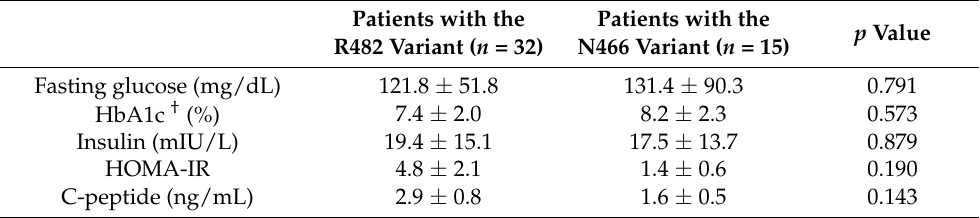
Table 4. Analytical data of FPLD2 patients depending on the variant in exon 8 of the LMNA gene. Patients with the Patients with the R482 Variant ( n = 32) N466 Variant ( n =